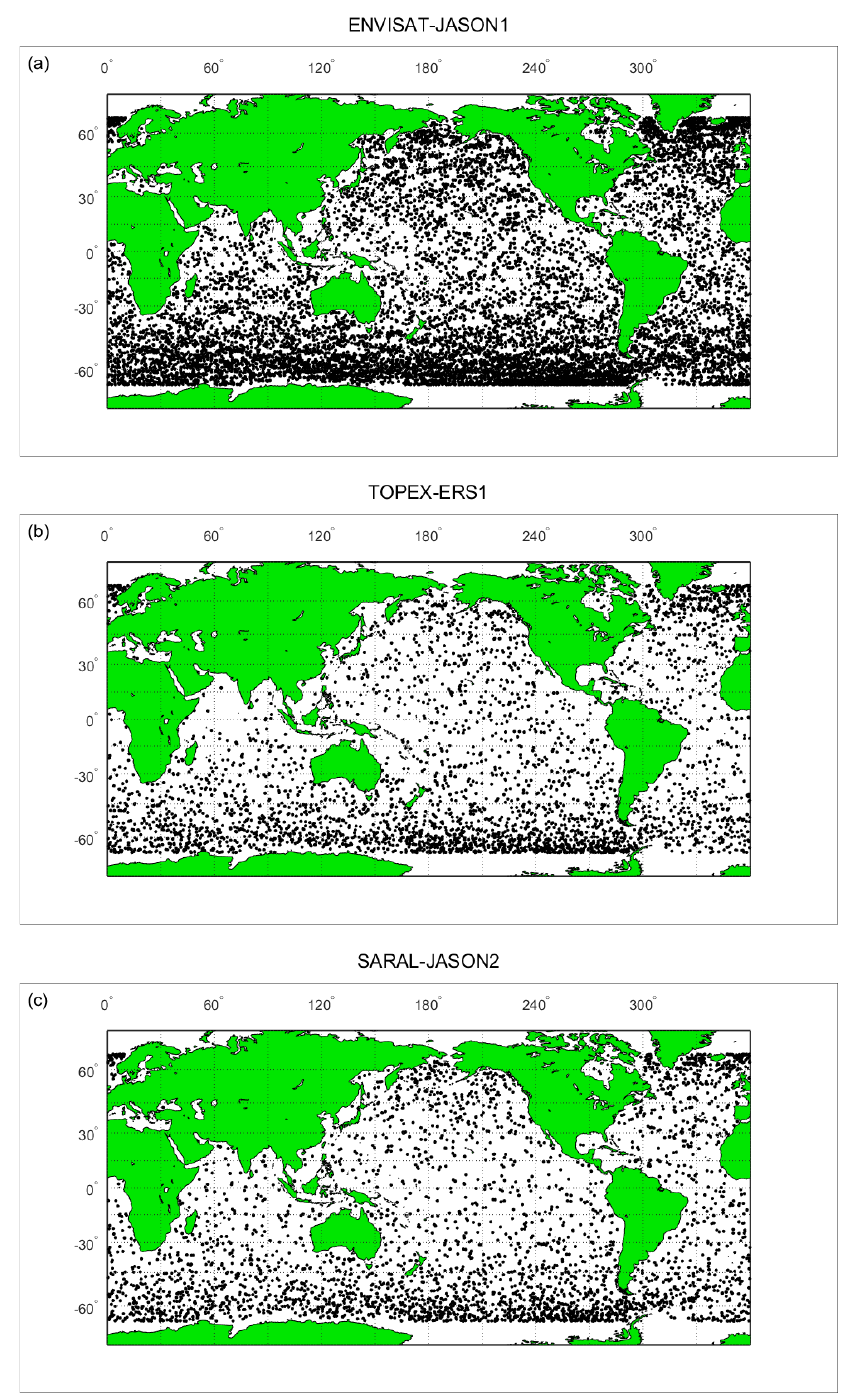
Figure 3. Matchup locations used for the “altimeter–altimeter” calibrations of ( a ) ENVISAT against JASON1, ( b ) ERS1 against TOPEX, and ( c ) SARAL against JASON2.